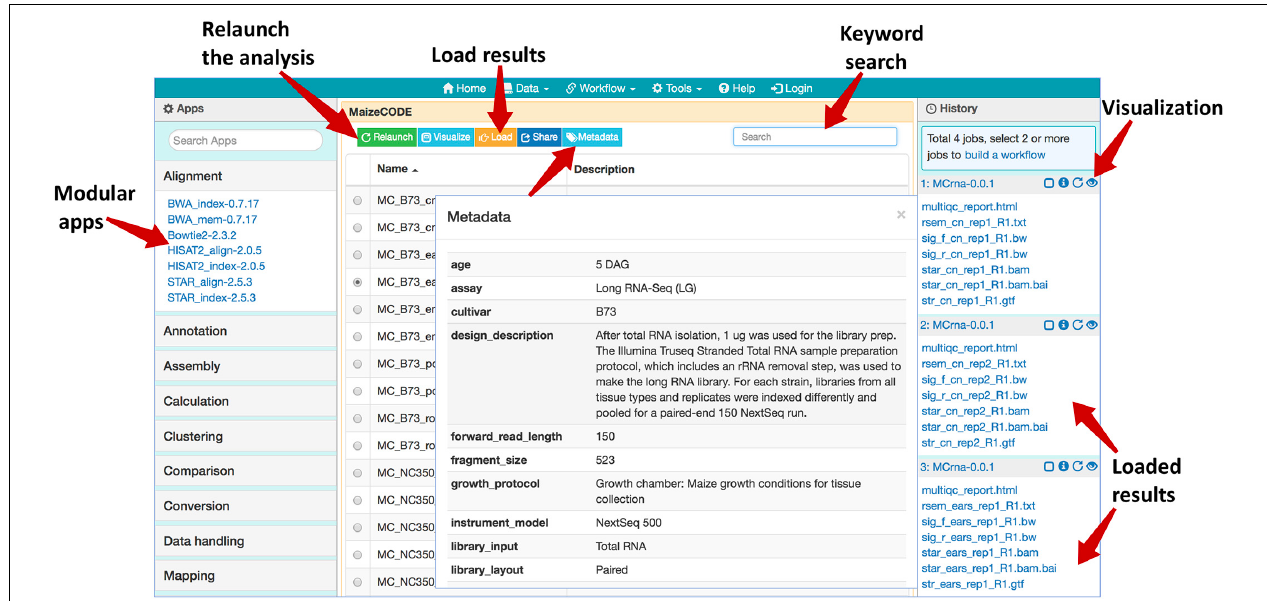
FIGURE 1 | Web browser interface of the MaizeCODE data page. In the middle panel page, a list of workflows/experiments is presented. Above the list, several action buttons are available: “Relaunch” the analysis, “Visualize” the graphic diagram of the workflow (with URLs for the raw sequence files from the input file node), “Load” the results to the History panel, “Share” the analysis with others, and display the experimental “Metadata”. User can perform a keyword search for a specific dataset (e.g., B73 ears RNA-Seq). In the right panel, SciApps displays the history of the selected datasets; the visualization (eye) icon opens a panel where users can generate links to visualize the results in a web browser (e.g., a QC report) or genome browser (e.g., alignments or signal tracks). The left panel shows a list of modular apps that can be launched to perform a variety of downstream analyses with the loaded results.